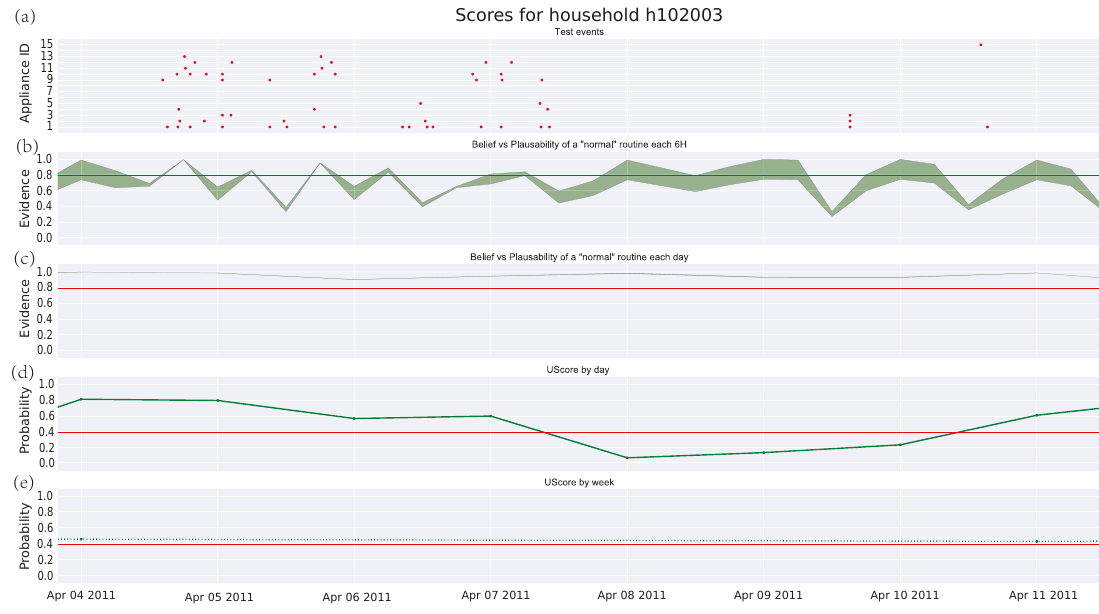
Figure 6. Score for test events in household No. 102003 from HES dataset during a week: ( a ) test events; ( b ) DST score every 6 h; ( c ) DST score by day; ( d ) union probability score by day; and ( e ) union probability score by